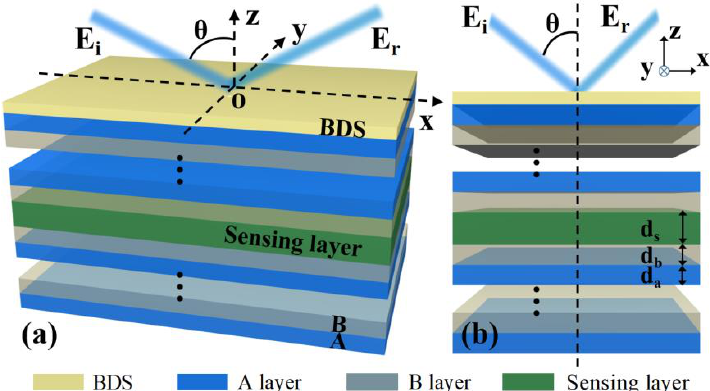
Figure 1. Schematic diagram of THz biosensor based on BDS/1D PC multilayer structure, where the sensing layer is embedded between two symmetrical 1D PCs, and BDS is placed at the top of the whole multilayer structure. ( a ) Visual view and ( b ) side view.